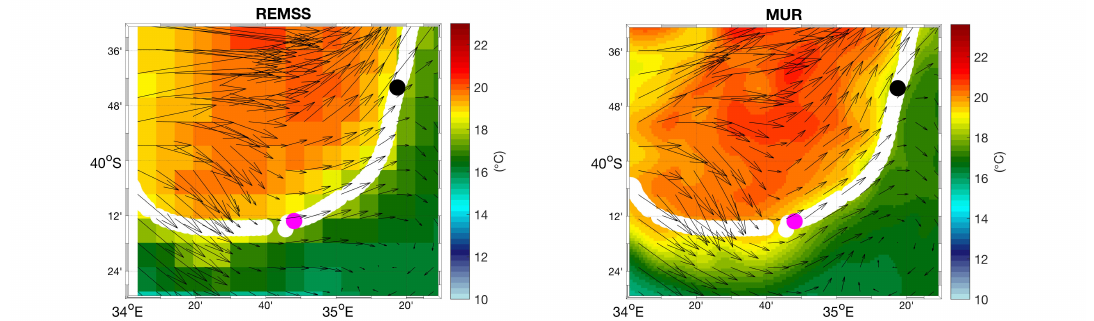
Figure 7. Optimal current vectors (black arrows) based on the REMSS and MUR SST reconstruction. The SST field is given in colors. The trajectory of a drifter is given in white. The magenta and black dots respectively stand for the buoy position from 25 March 2015 (00 UTC) to 26 March 2015 (00 UTC). The gridded fields represent 25 March 2015.